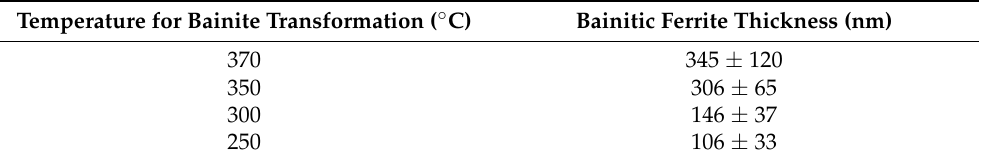
Figure 6. SEM micrograph of the sample treated with a single-step austempering until completion of the bainitic transformation at ( A ) 370 °C and ( B ) 350 °C. RAF: retained austenite film; BF: bainitic ferrite; RAB: retained austenite block; M: martensite. Table 4. Resume on the measurements on the bainitic ferrite formed at the various isothermal holding